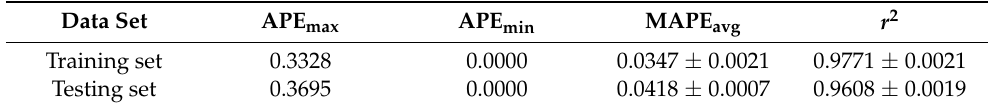
Table 5. The average forecasting performance of the HKF-SVR-GA